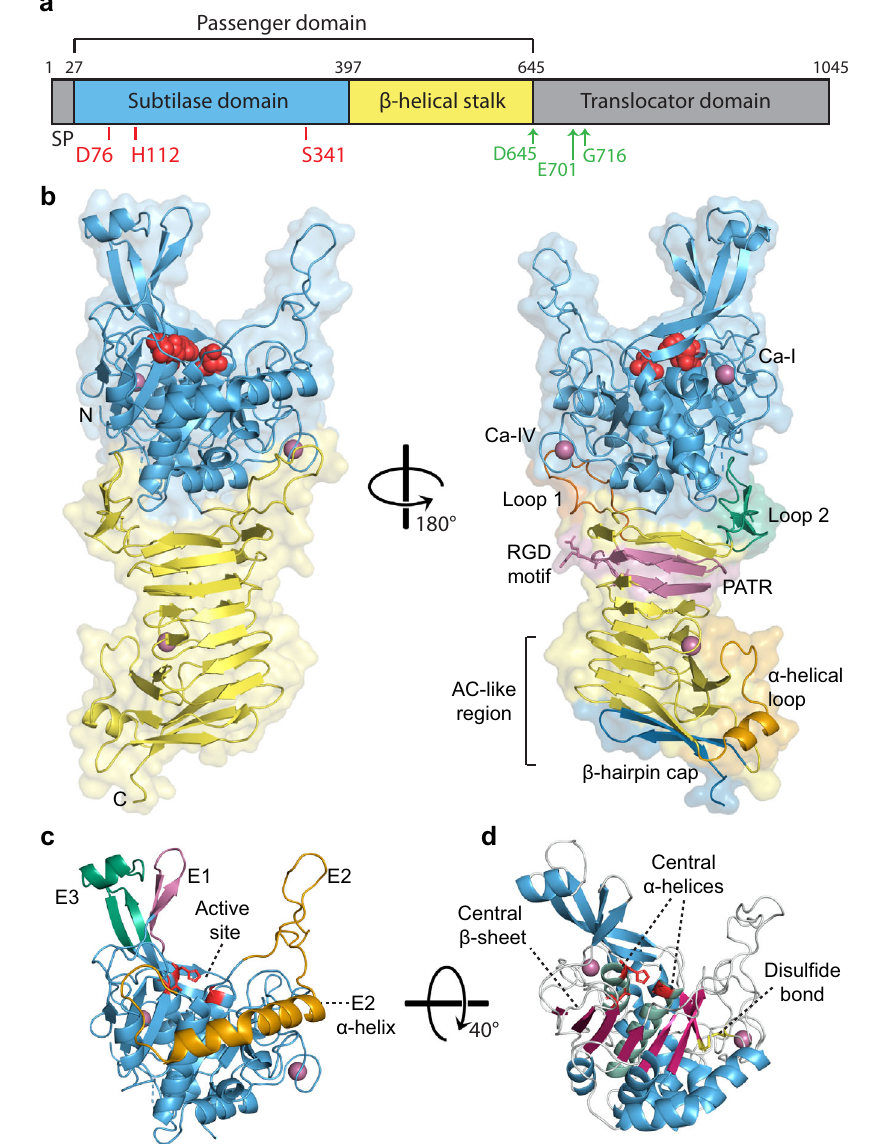
Fig. 1 | Structure of Ssp. a Linear schematic of Ssp ’ s primary sequence encom- passing an N-terminal signal peptide (SP) and a C-terminal translocator domain fl anking the central passenger. Active site residues in the subtilase domain are shown by red line, self-cleavage sites shown by green arrows. b Crystal structure showing overall architecture of Ssp passenger in cartoon representation. Subtilase (protease) domain is depicted in blue with active site residues shown as red spheres.The β -helicalstalkdomainisrepresentedinyellow,withprotruding β -helix Loop 1 and Loop 2, coloured in rust and green, respectively. The passenger- associated-transport-repeat (PATR) is displayed in pink and the RGD motif shown